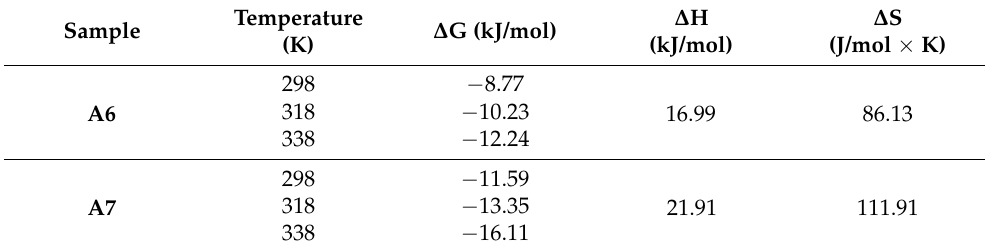
Table 8. Thermodynamic parameters of the adsorption of methylene blue on A6 andA7 samples.